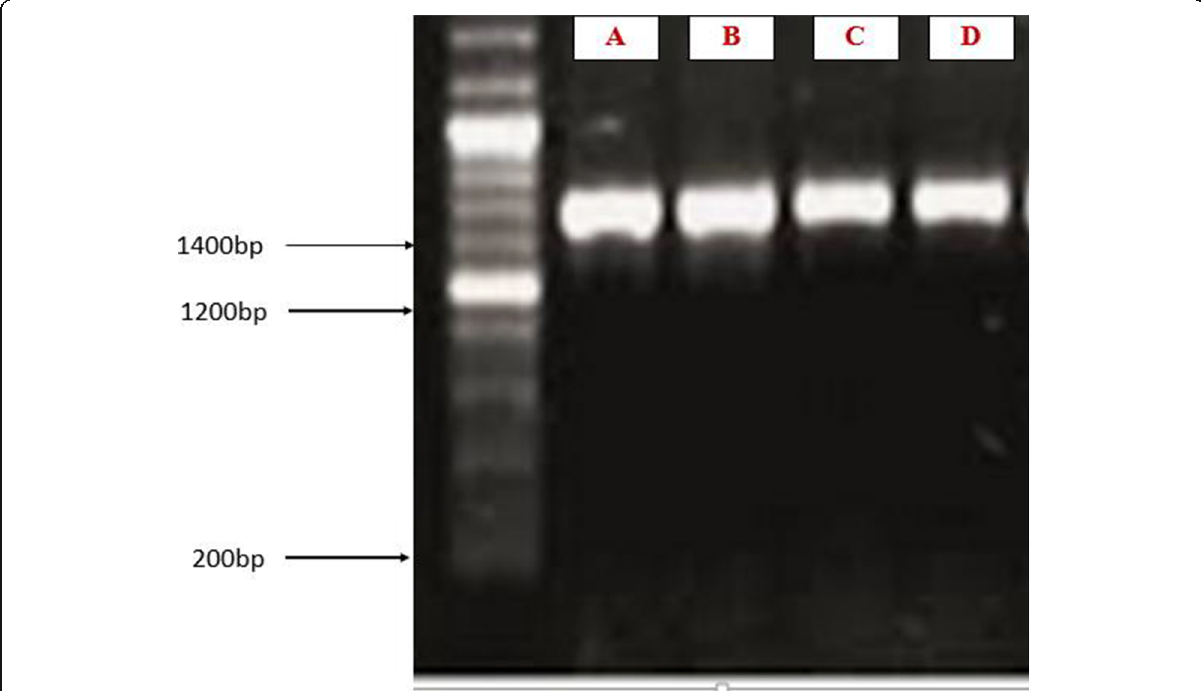
Fig. 8 Maximum tolerable level (MTL) of bacteria to different heavy